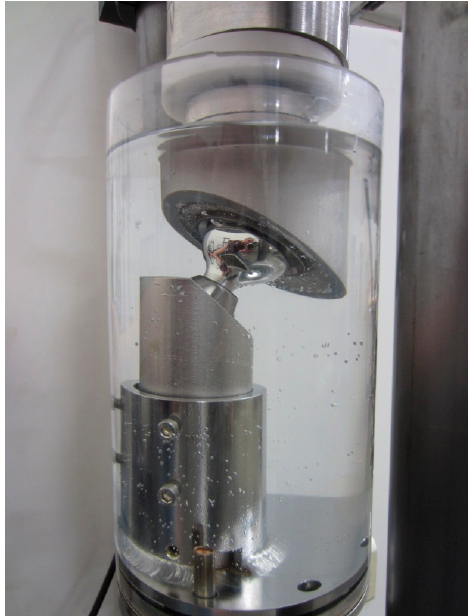
Figure 1. Hip Innovation Technology (HIT) Hip Replacement System (HRS).